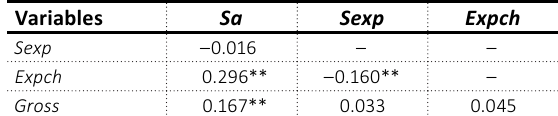
Table 4. Correlation